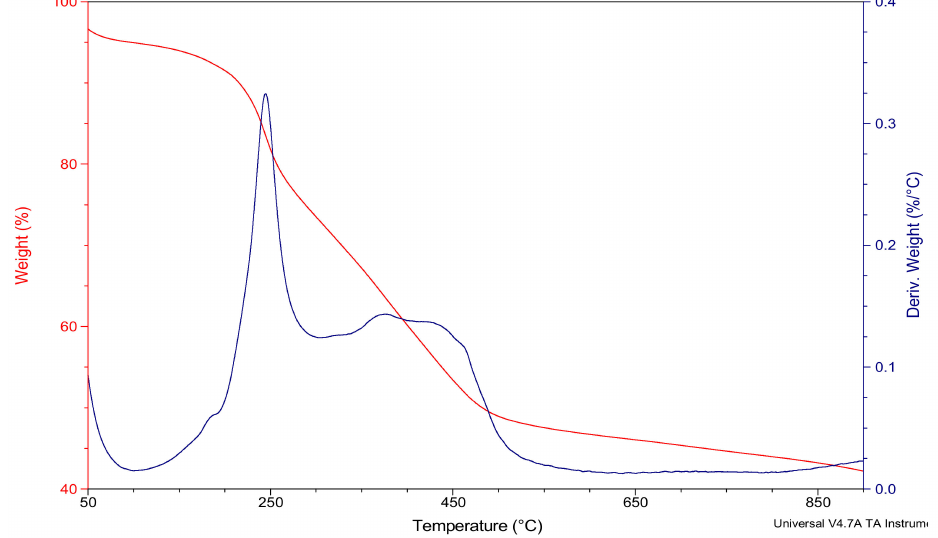
Figure 2. TGA spectra of MWCNT@celllulose nanocomposite showing degradation